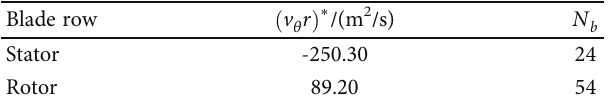
Table 3: Input blade row parameters of the single-stage